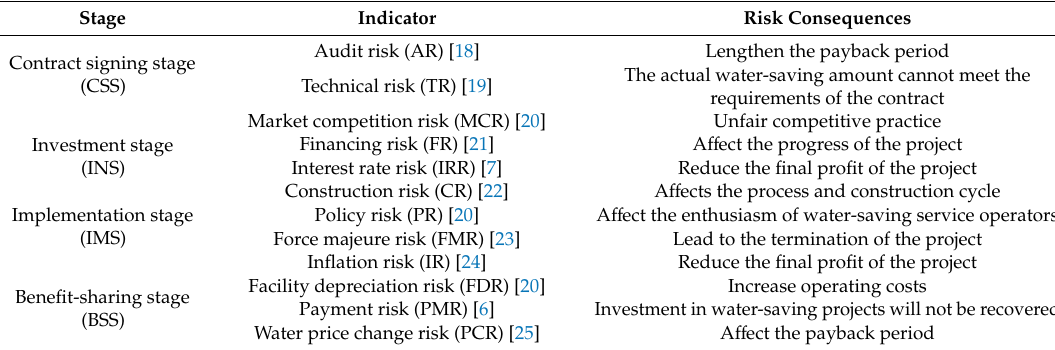
Table 1. Risk index system of WSC